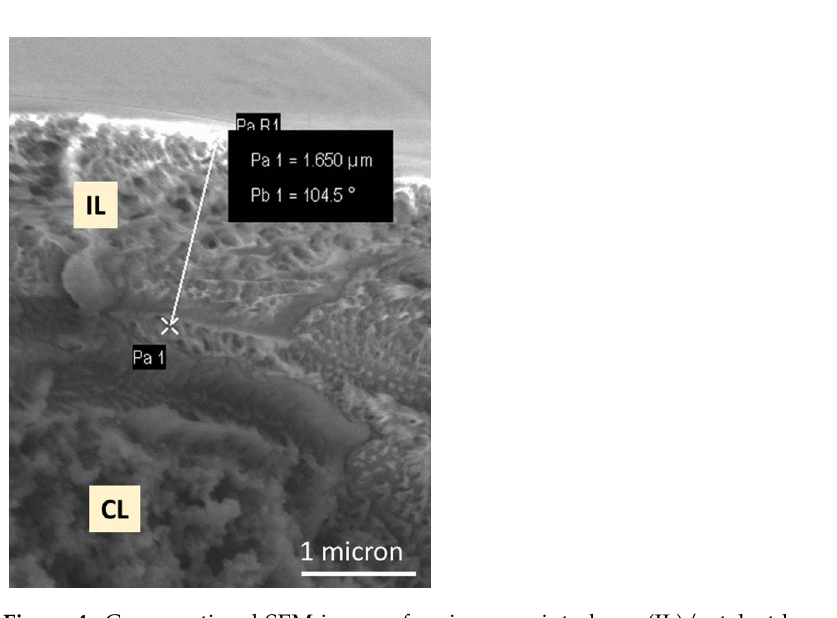
Figure 4. Cross-sectional SEM image of an ionomer interlayer (IL)/catalyst layer (CL) interface, showing the ca. 1.7 µ m interlayer protruding from the catalyst layer.